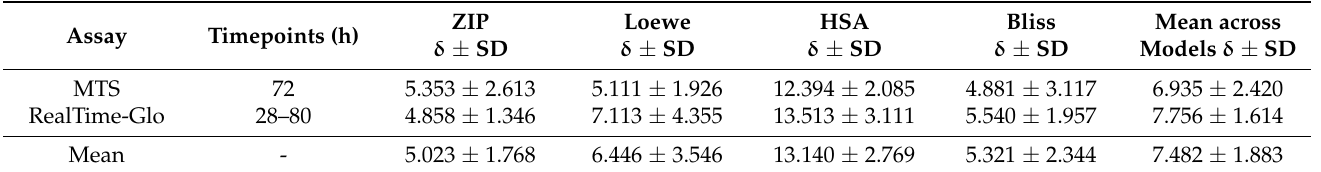
Figure 4. Curve shift for Trametinib combination with HDM201. MTS assay, mean from n = 4. Table 4. Drug interaction between Siremadlin and Trametinib in A375 cells. For MTS assay, n = 4, and for RealTime-Glo assay, n = 3. Synergyfinder package analysis.